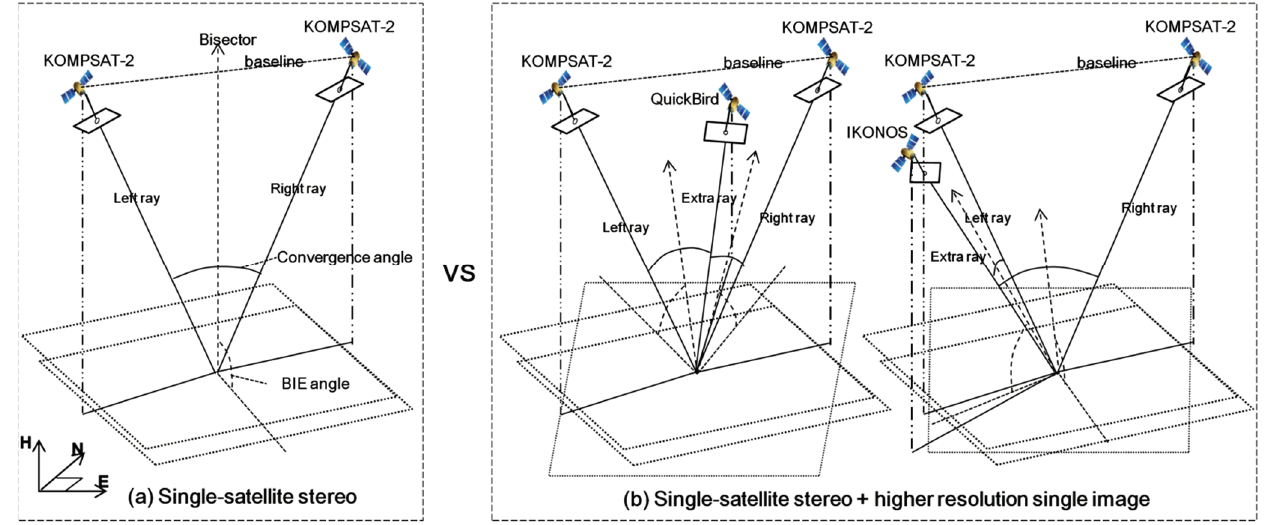
Figure 4. Test cases for comparison before and after the integration of higher resolution single image. ( a ) single-satellite stereo, ( b ) single-satellite stereo + higher resolution single